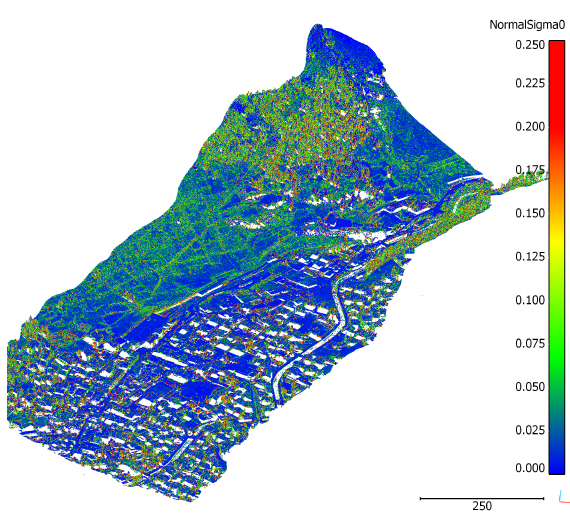
Figure 6: ALS point cloud of Figure 2, colour-coded by the σ 0 value a posteriori of normal vector estimation.